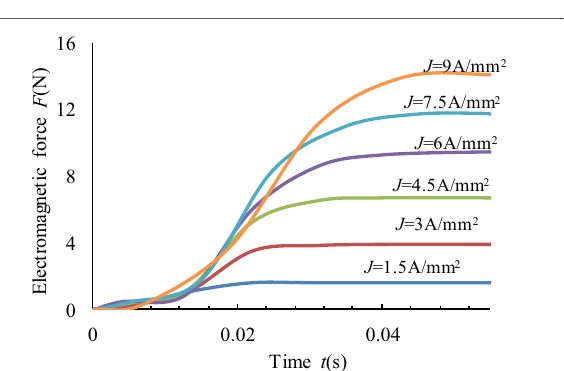
Figure 16 Output force rising time curve of the inner